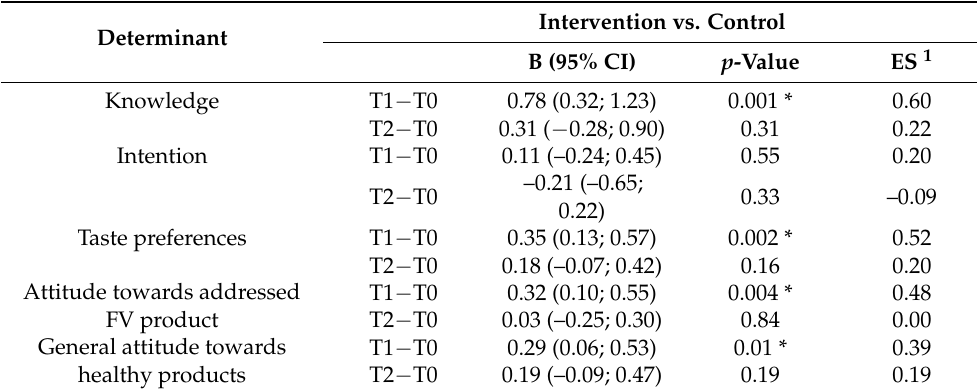
Table 2. Estimated Treatment Effects after Multiple Imputation (n = 192).